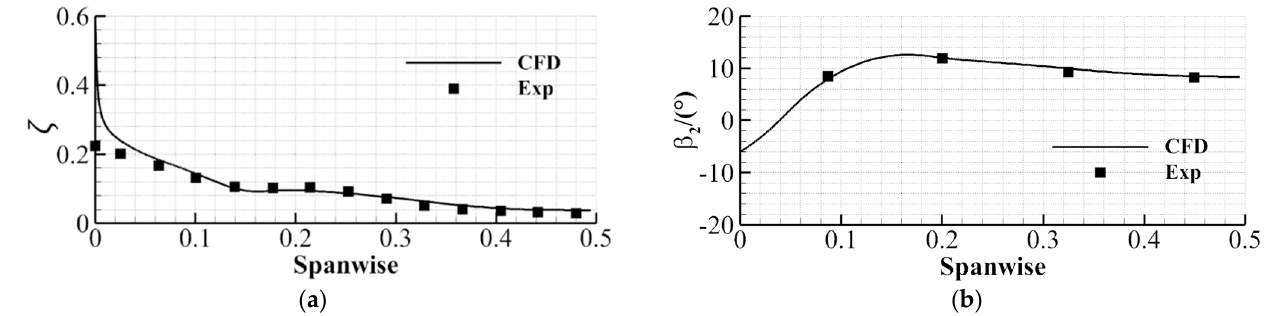
Figure 6. Comparison between the numerical and experimental results of the original cascade at design condition: ( a ) Outlet total pressure loss coefficient distribution; ( b ) Outlet flow angle distribution.